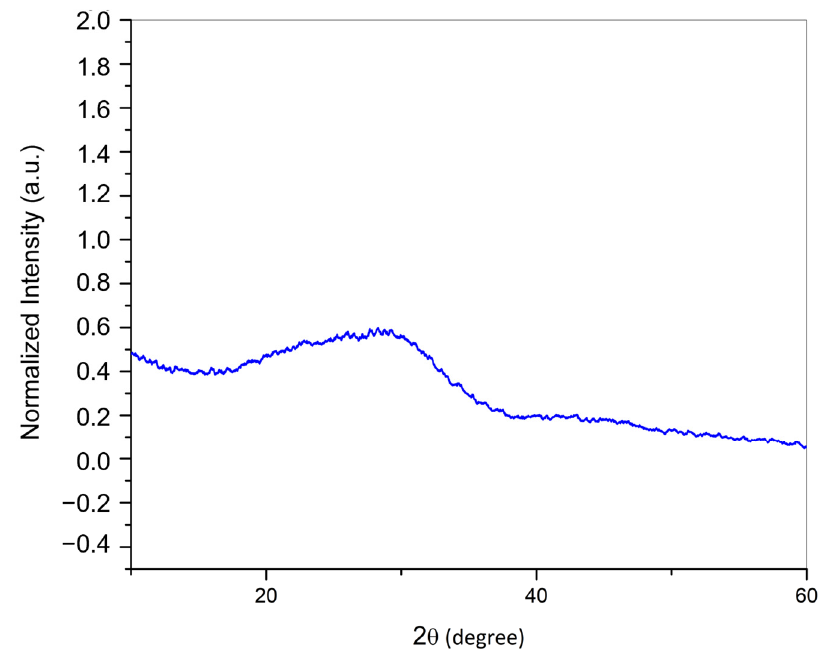
Figure 3. Results of X-ray diffraction analysis (XRD) of the calcium-polyphosphate